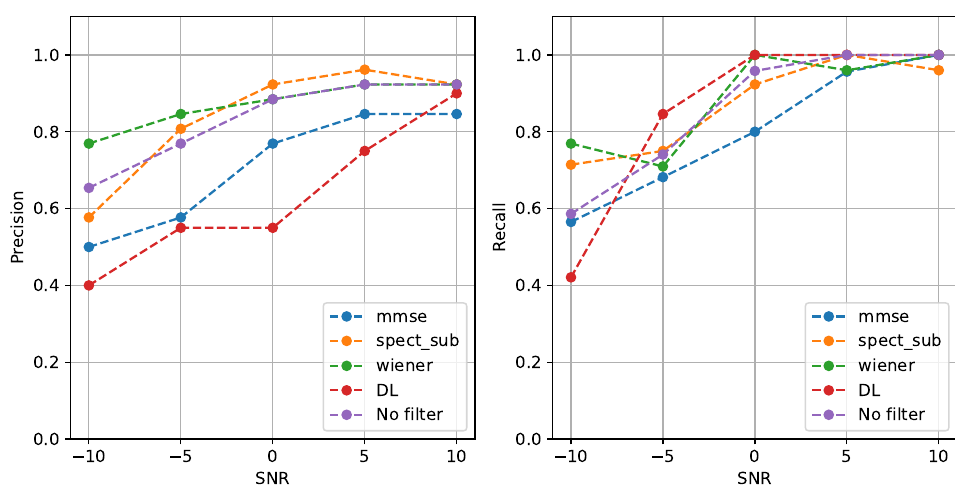
Figure 4. Comparison of Precision and Recall results for